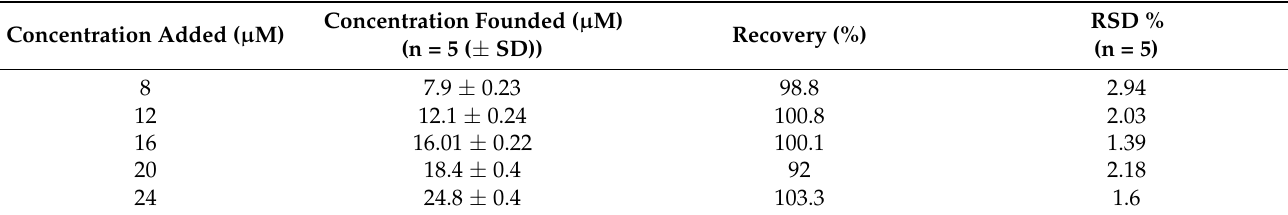
Table 3. Recovery of dibucaine in serum (BSA